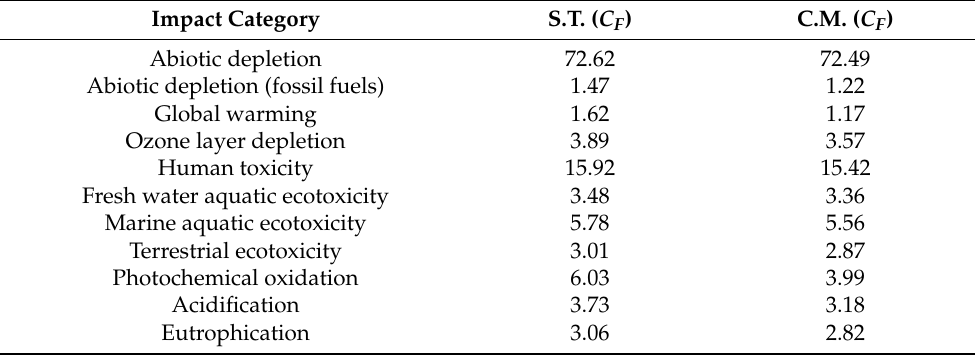
Table 12. C F values for impacts equivalent to Thai